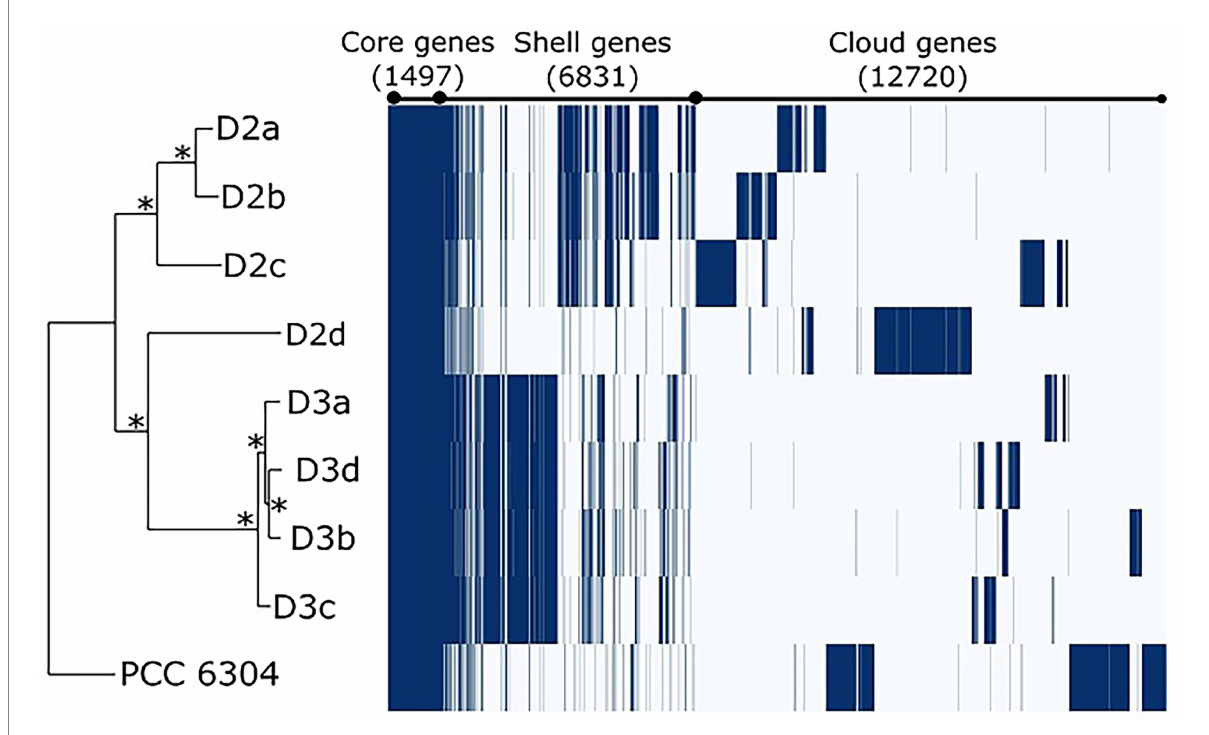
FIGURE 3 Gene presence and absence matrix from pangenome analysis of 8 Laspinema strains and “Oscillatoria” acuminata (marked PCC 6304) inferred by Roary (Page et al., 2015). Core genes represent genes present in all strains, shell genes appear in 2–8, while cloud genes are in a single strain. Each row corresponds to the branch of the phylogenetic tree, while each column represents the orthologous gene family. The dark blue line indicates the presence of a gene, while the white blocks indicate the absence of a gene. Asterisks in the ML tree indicate bootstrap values of